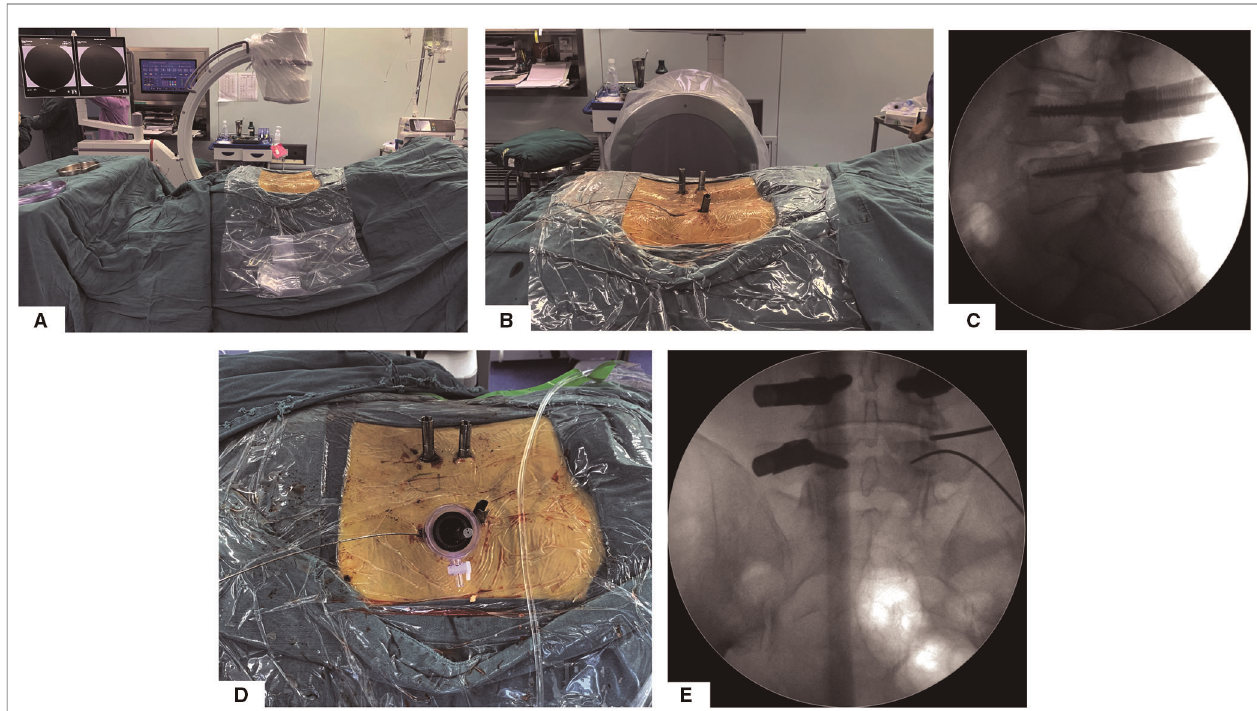
FIGURE 1 | Surgery position, percutaneous pedicle screw fi xation, and establishment of endoscopic working channel. ( A ) Prone surgery position and C-arm position. ( B ) General view of surgical incision and percutaneous pedicle screw implantation. ( C ) Lateral view of percutaneous pedicle screw fi xation. ( D ) General view after establishing working channel. ( E ) AP view after establishing working